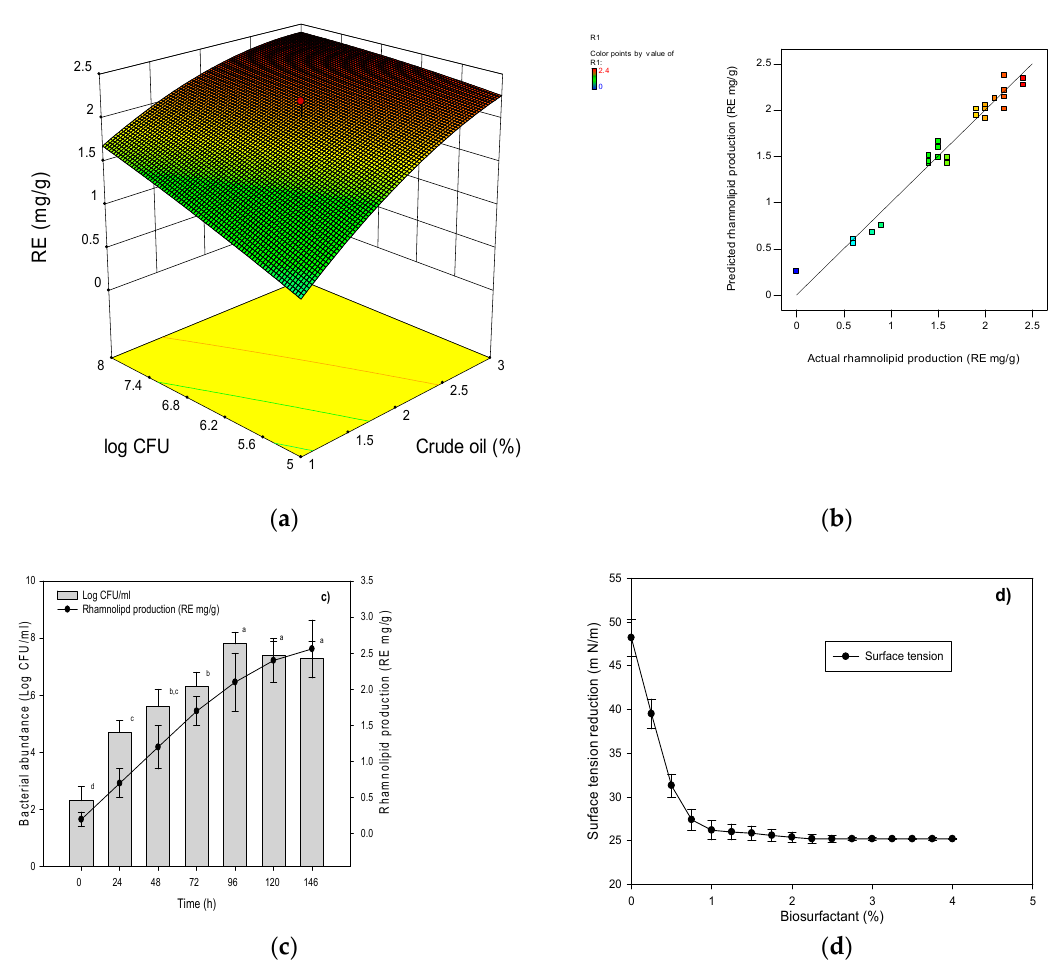
Figure 2. ( a ) Three-dimensional contour plot for maximum rhamnolipid production expressed as RE (rhamnose equivalents) mg g − 1 cell dry weight as a function of inoculation load and crude oil (%), ( b ) Predicted vs. actual values for rhamnolipid production based on response surface methology ( c ) Growth and rhamnolipid production in RSM optimized media, ( d ) Graph of surface tension vs. concentration of the rhamnolipid. Different lower case letters after values indicate a significant difference at a p -value of 0.05 as determined by Duncan’s multiple range test